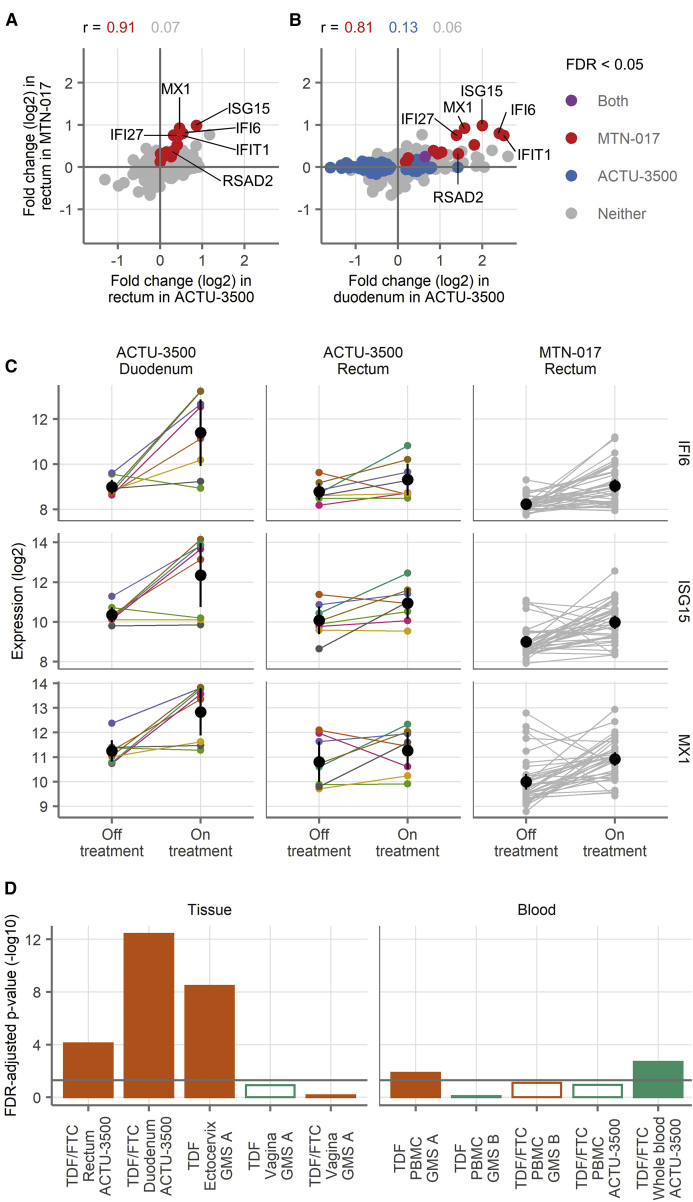
Gene Expression across Study Arms by Microarray Analysis(A and B) Fold changes of all genes detected in the rectal samples in MTN-017 compared to the rectal samples from ACTU-3500 (A) and the duodenal samples from ACTU-3500 (B). The colors indicate genes with FDR-adjusted p < 0.05 in MTN-017 (red), ACTU-3500 (blue), both (purple), or neither (gray). Spearman correlation coefficients for the genes falling into each subset are shown.(C) Expression levels of IFI6, ISG15, and MX1 in individual samples. Small points indicate measurements from a single biopsy, with lines connecting the matching observation from the same donor. For ACTU-3500, the color of the lines and symbols indicate the participant and are consistent across the panels. The black symbols and vertical lines show the means and 95% confidence intervals of the mean.(D) Gene set testing of a custom gene set composed of differentially expressed genes from the rectum in MTN-017 performed in the other study arms in the mucosa (left) and blood (right), comparing the expression of genes in the set to all of the other detected genes within each study arm. The bars indicate the result of a test against the study labeled on the x axis. The filled bars indicate an FDR-adjusted p < 0.05 and open symbols the opposite, with the bar height showing the −log10 of the FDR-adjusted p value. The colors indicate the direction of change, with orange indicating more expression during product use and green indicating the opposite. The horizontal gray line shows an FDR-adjusted p = 0.05. The sample sizes are shown in Table 1. Each sample was run in singlicate by microarray.